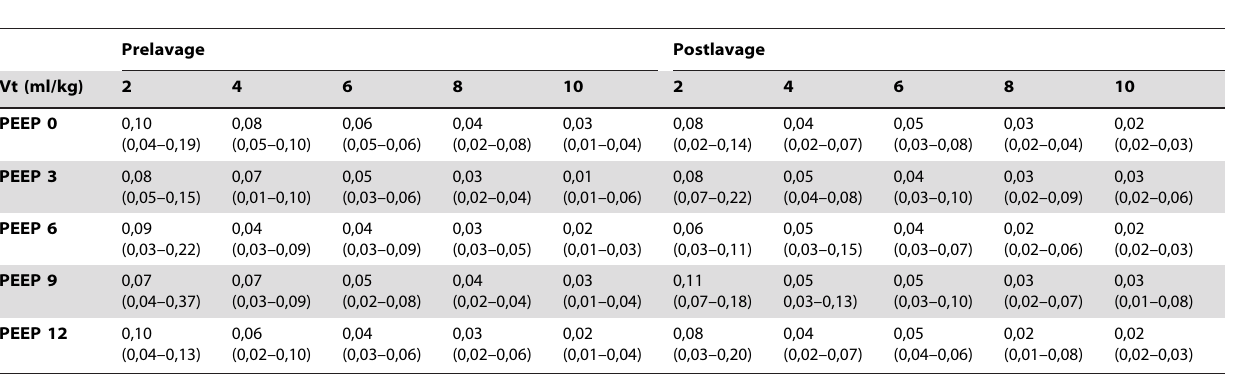
Shown are median (range) coefficients of variation (CV) of repeated tTI measurements for corresponding VT levels at different PEEP levels Pre- and Post-lavage for n=5 animals. Repeated measurements are taken at different time points during variation at one PEEP